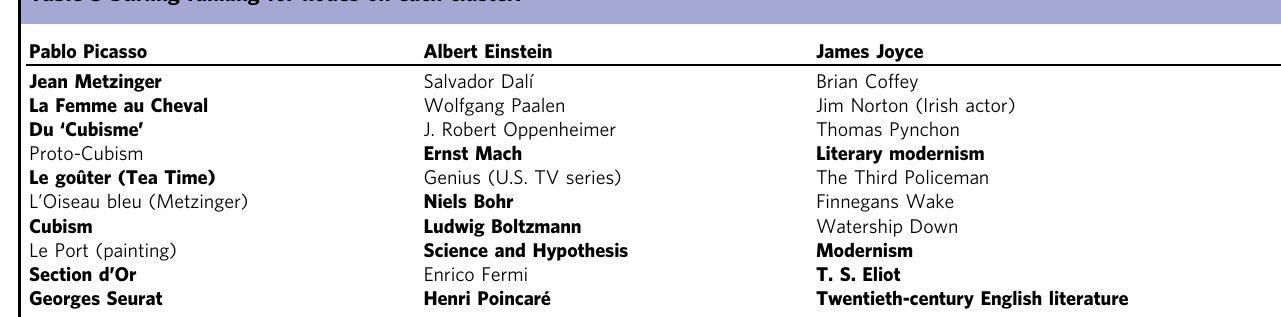
Table 3 Stirling ranking for nodes on each cluster.